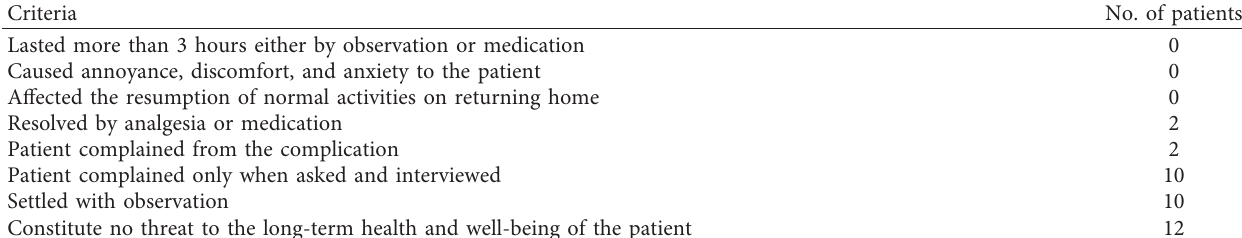
Table 5: Prespecified adopted criteria against which the complications were evaluated.